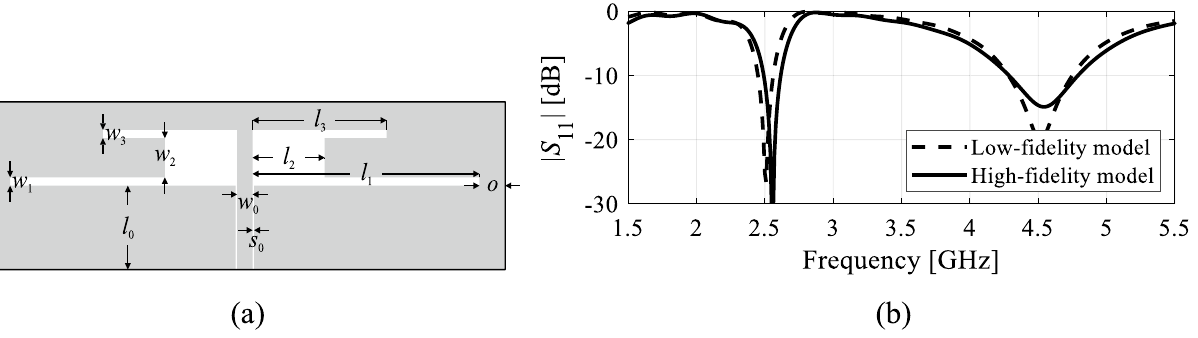
Figure 4. Variable-fidelity models: ( a ) an exemplary dual-band antenna, ( b ) antenna reflection responses evaluated with the low-fidelity EM model (- - -) and the high-fidelity one (—). Here, the high-fidelity model simulation time is about 80 s, whereas the time of the coarse model is only 25